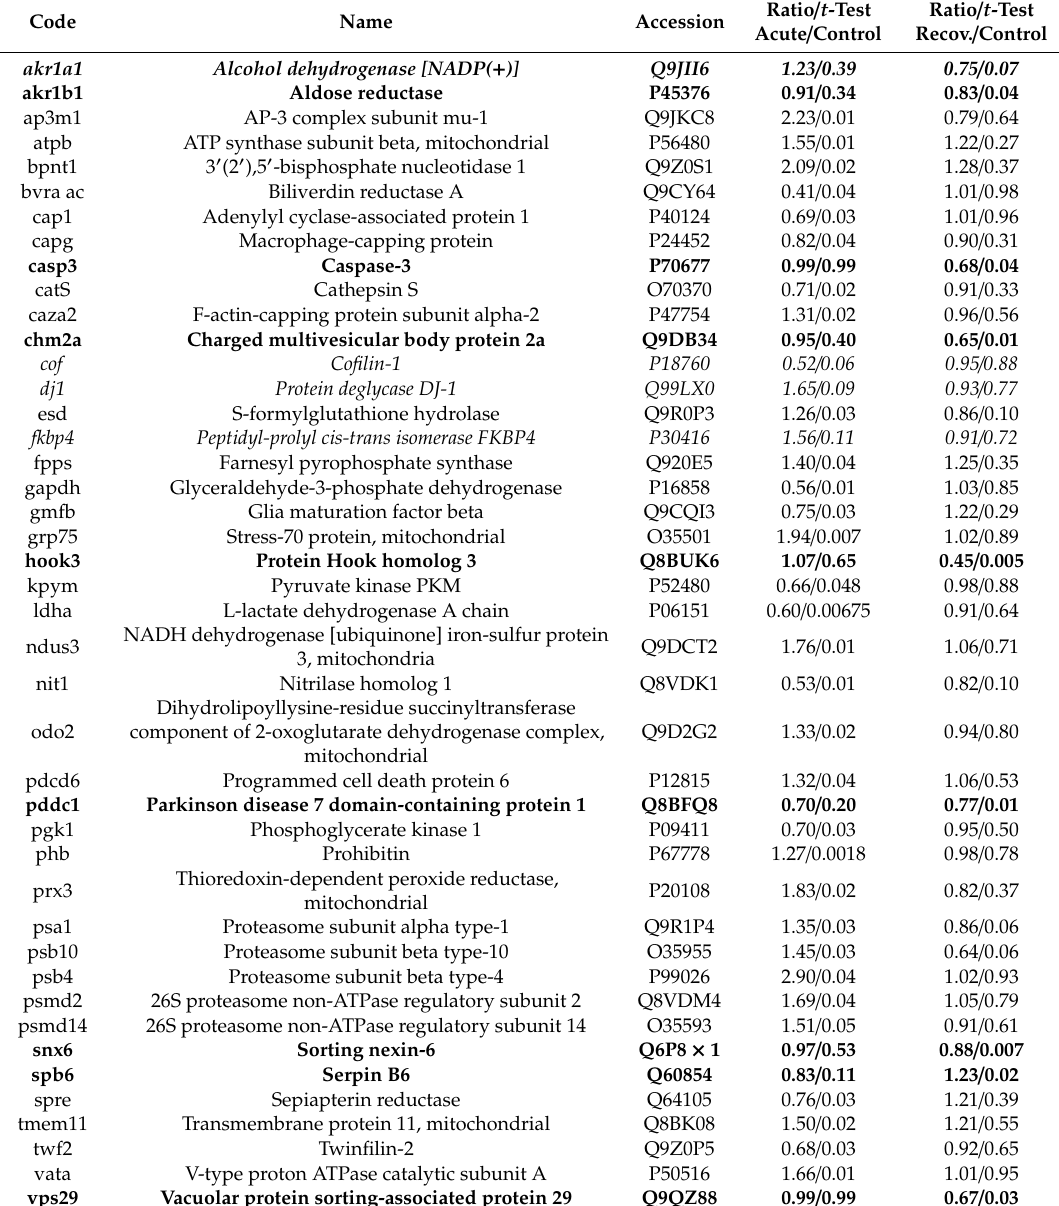
Bold: proteins with a change greater in amplitude at the end of the recovery period compared to the change observed immediately after exposure. Italics: proteins showing a significant change by the Mann–Whitney U test but not by the Student t